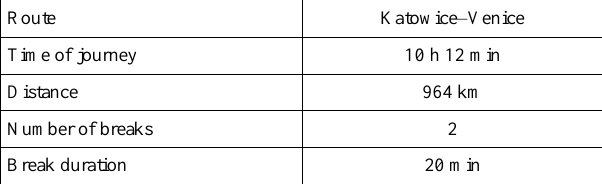
Table 1. Route details generated for ICE vehicle in “Google Maps”